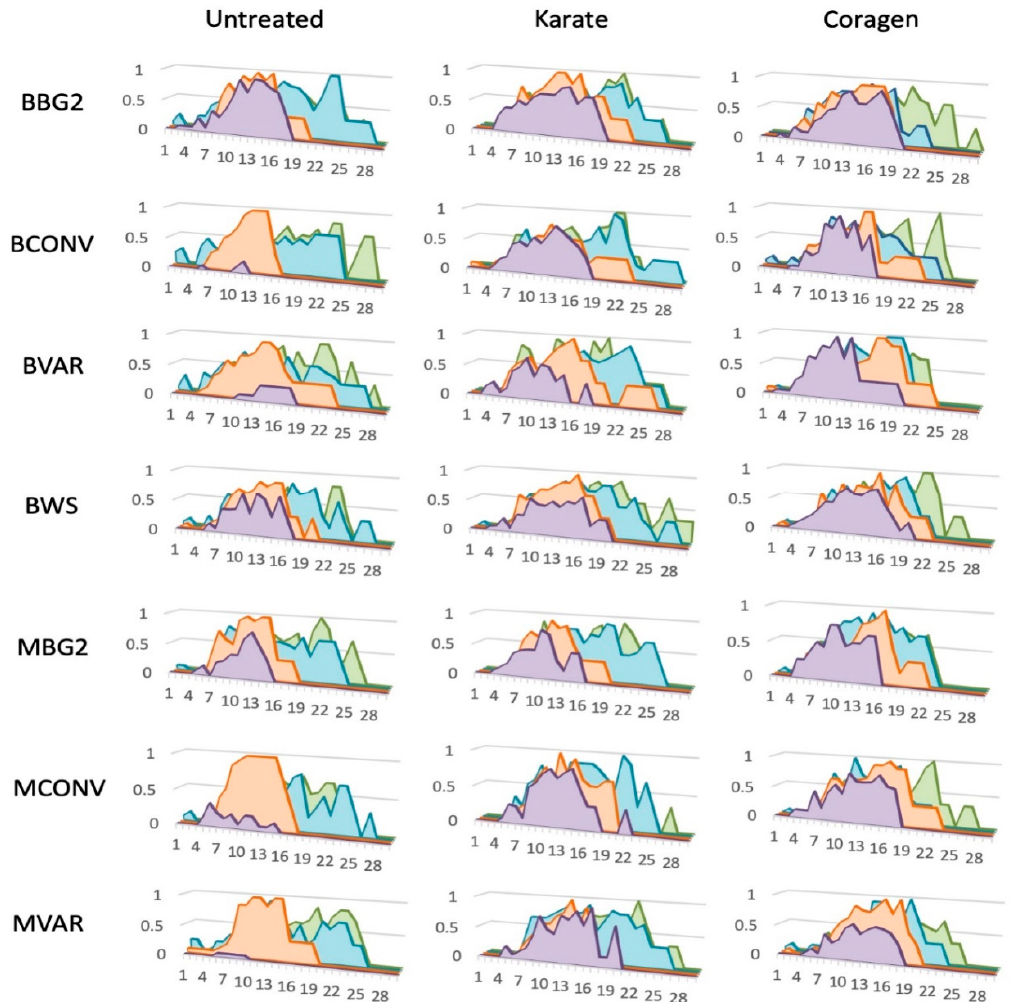
Figure 1. Retention of 1st position fruit (probability of fruit at different mainstem nodes) on different plant mapping dates and at harvest during 2011. Plant mapping is indicated on 13 July 2011 (orange), 25 July 2011 (blue), 1 August 2011 (green) and at harvest (6 October 2011; purple). The x -axis indicates the mainstem node number (from bottom to top of plant), while the y -axis indicates probability of fruit at each node.